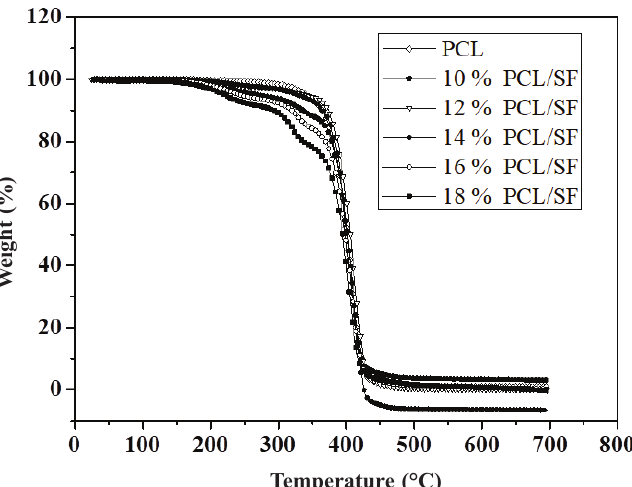
Fig. 8 – TG curves of the electrospun PCL and PCL/SF scaffolds